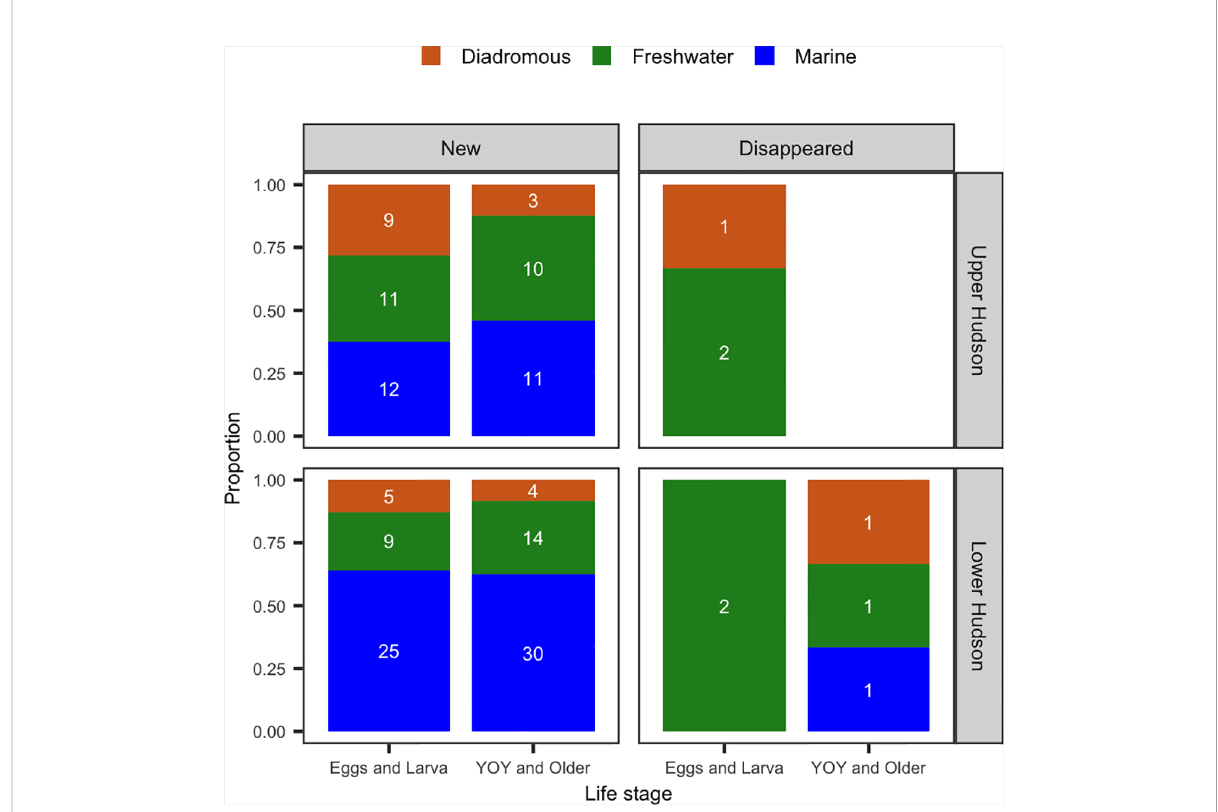
FIGURE 7 Numbers and proportions of new and disappeared species in phase 2 for E&L (eggs and larva) and Y&O (young-of-year and older) groups during May-July from 1974 to 2017 in the upper and lower